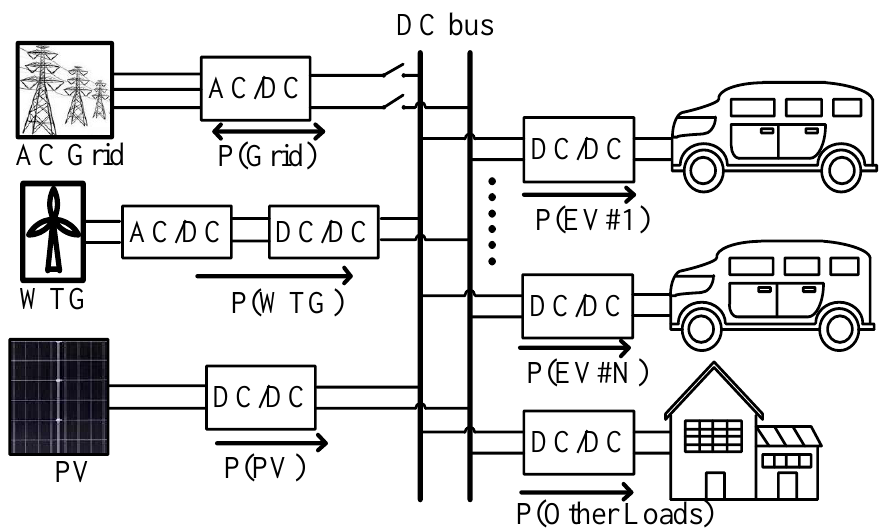
Figure 7. Typical system configuration of a grid-connected ECS with RE-based power generation.